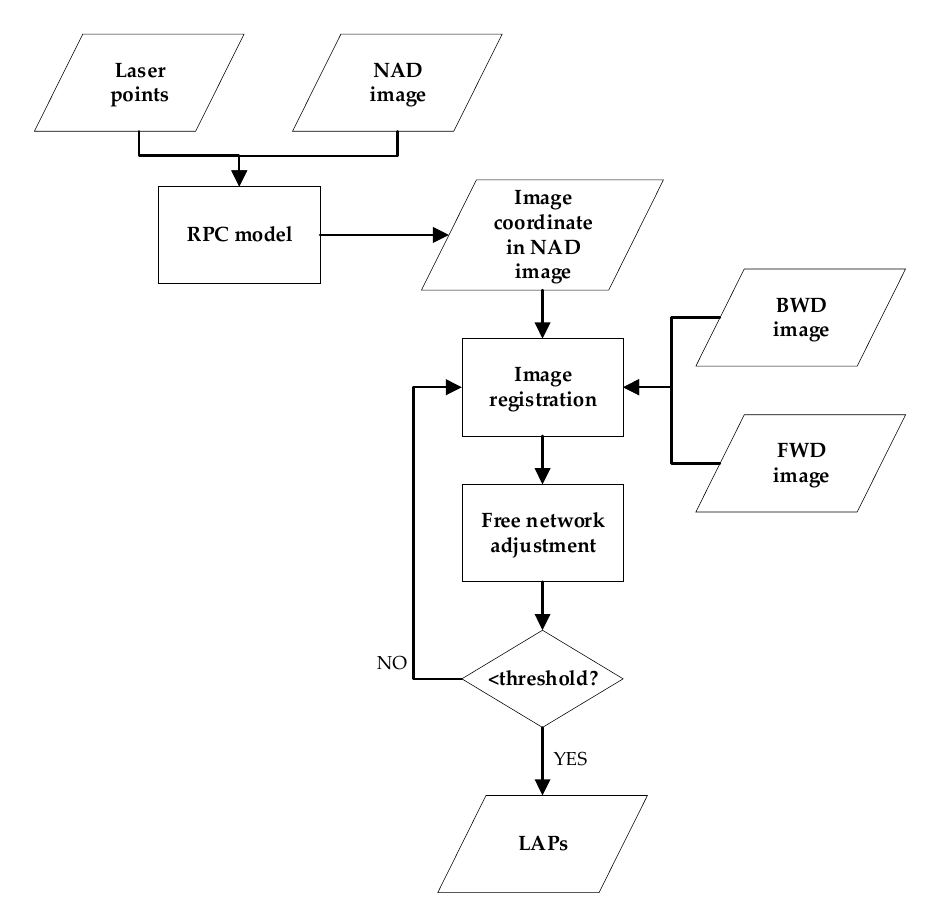
Figure 5. LAPs Extraction